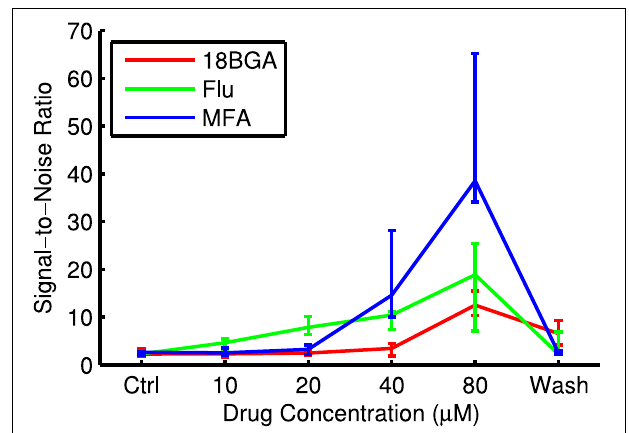
FIGURE 6 | Signal-to-noise ratio for responses to the longest µ LED array flash at each drug concentration. Data points are median over all retinas of the median SNR of all cells that respond in both control conditions and at 80 µ M drug and had measurable SNR values. Error bars are IQR for all retinas.